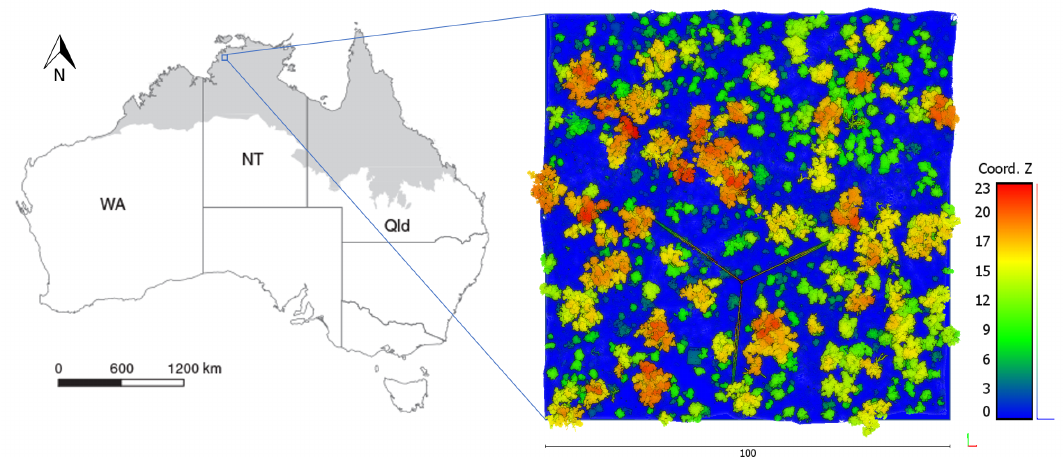
Figure 1. Study area. Left: The north Australian tropical zone spans across Western Australia (WA), the Northern Territory (NT), and Queensland (Qld). Right: canopy height model of the 1 ha study area from TLS (scale bar in m, color scale ranging from blue for lowest points through to red for highest points) showing heterogeneous distribution of tree size